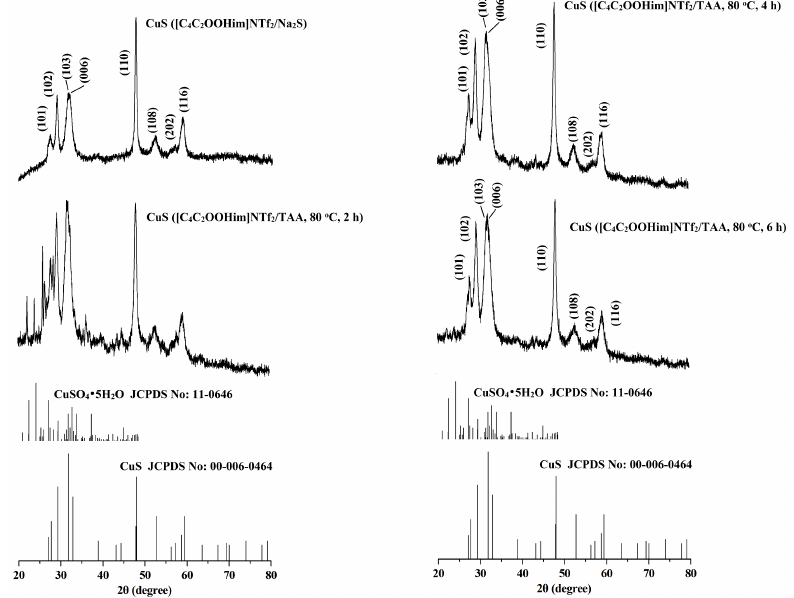
Figure 2. XRD patterns of the CuS prepared in the [C 4 C 2 OOHim]NTf 2 /water systems.